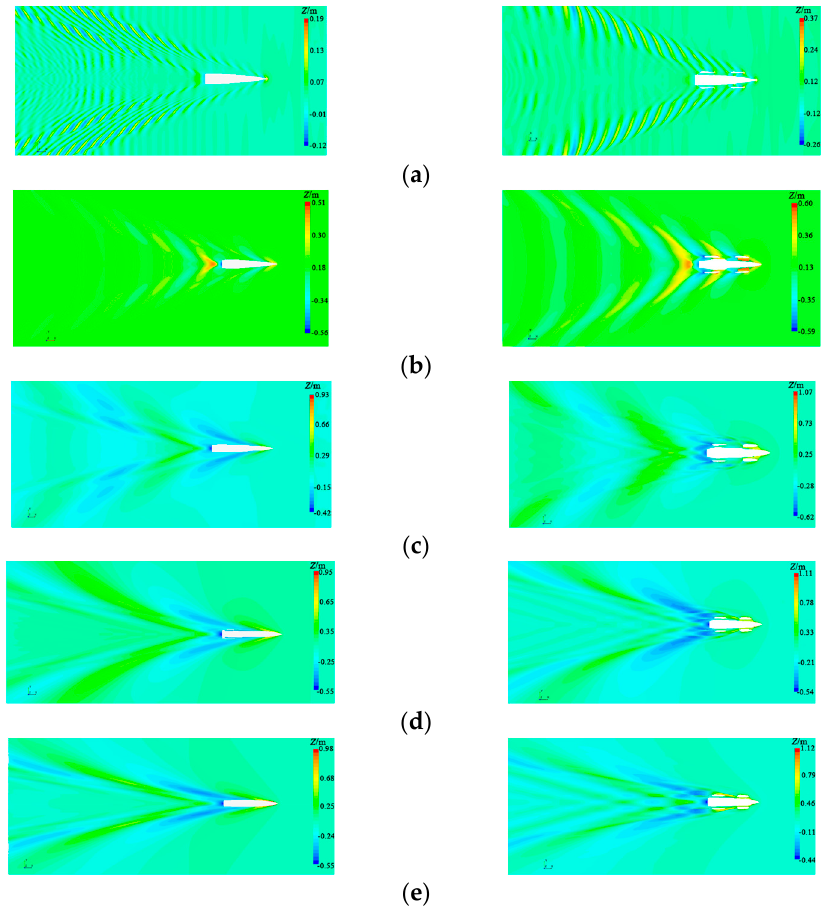
Figure 18. The wave patterns of monohull (left) and pentamaran (right) in calm water: ( a ) case 1; ( b ) case 2; ( c ) case 3; ( d ) case 4; ( e ) case 5.